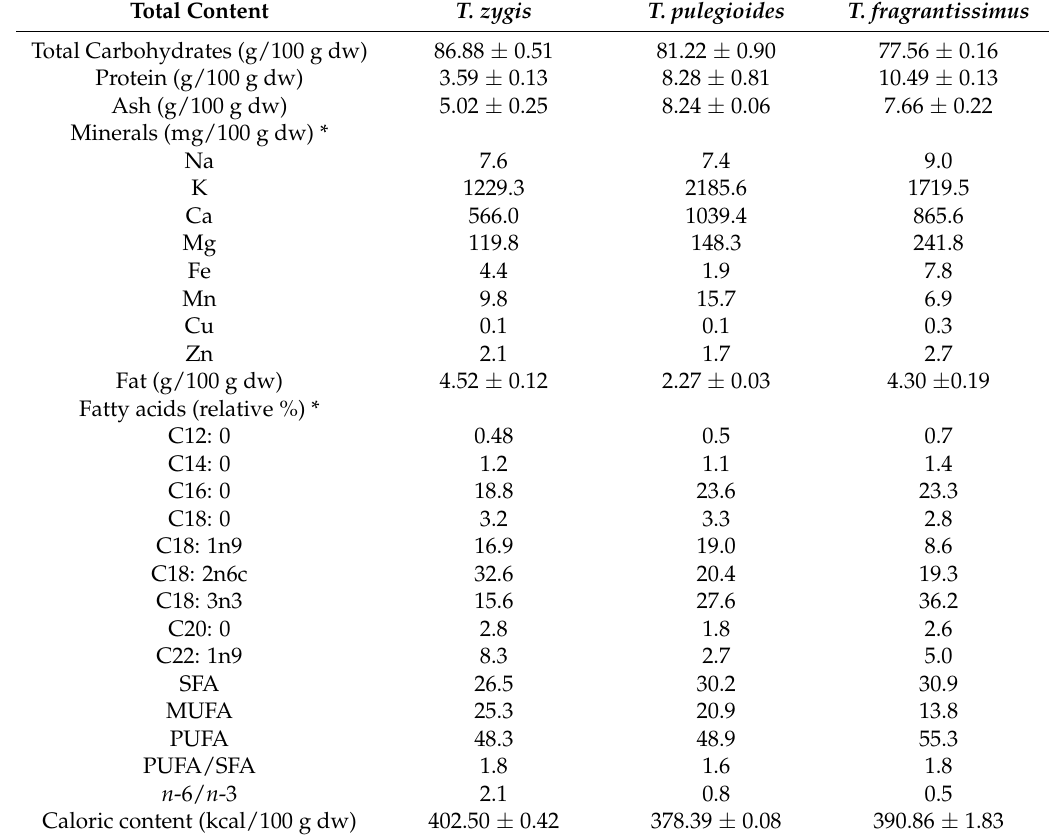
Table 1. Nutritional value of the three Thymus plant species.